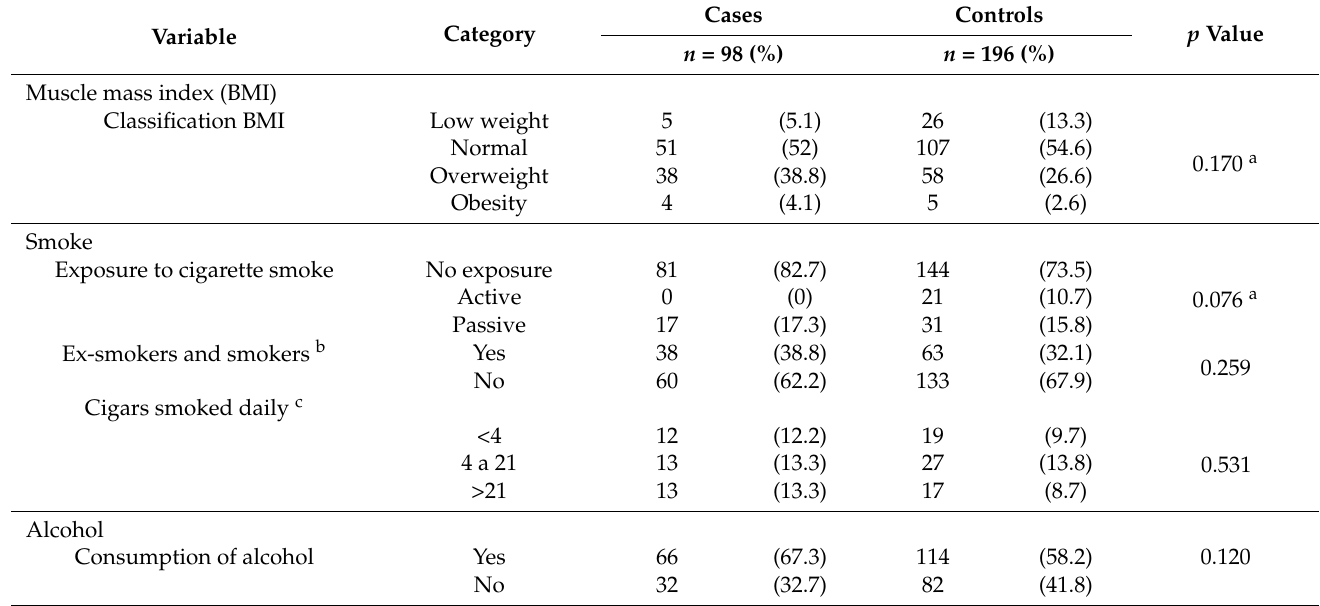
Table 3. Lifestyle factors in case and